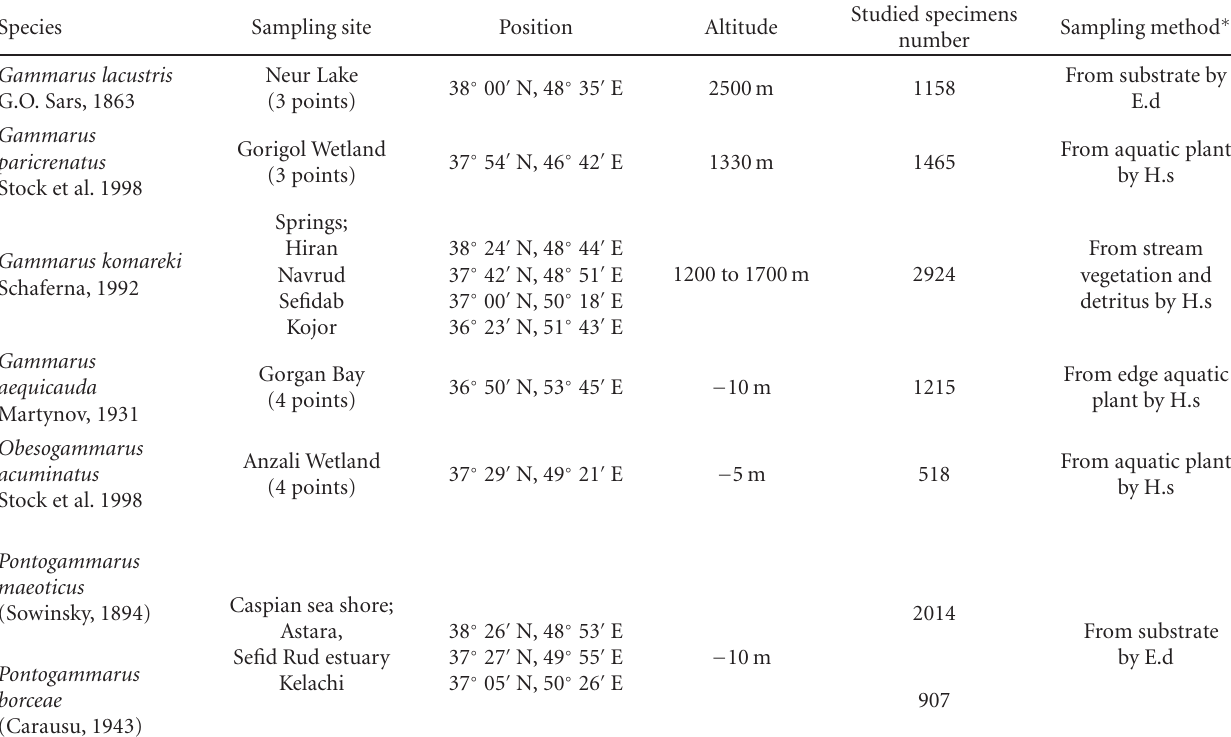
Table 1: Sampling localities for amphipods of the present